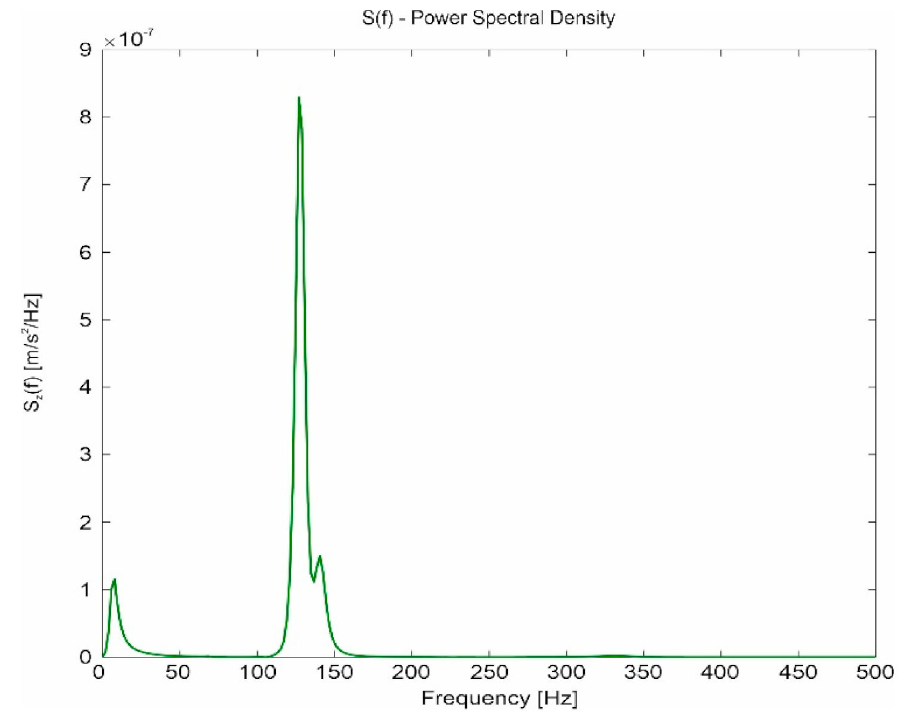
Figure27. Spectrumgeneratedfromaccelerationonthelevitationsysteminthedirection z for2000km /